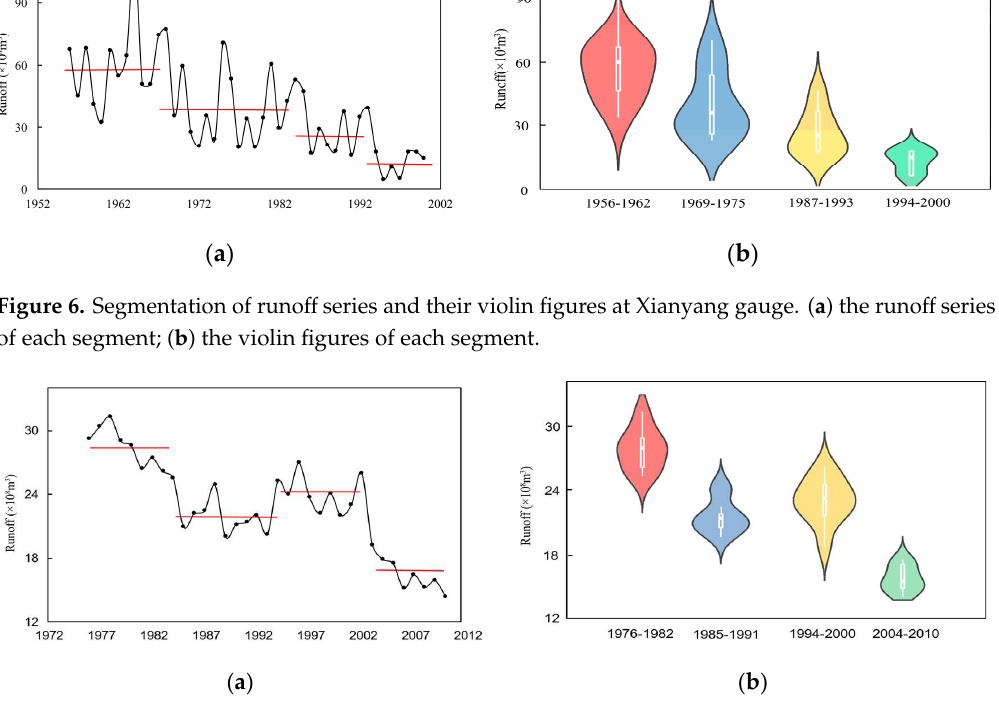
Figure 7. Segmentation of runoff series and their violin figures at Gaojiabao gauge. (a) the runoff series of each segment; (b) the violin figures of each segment.